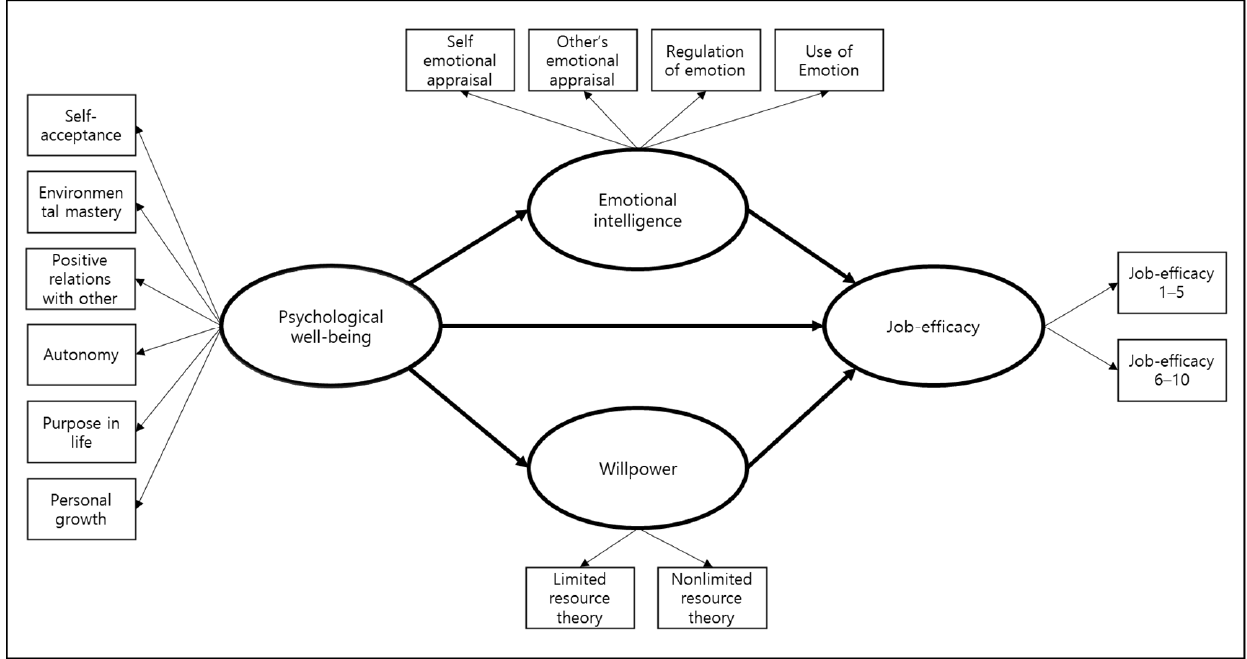
Figure 1. Study model.